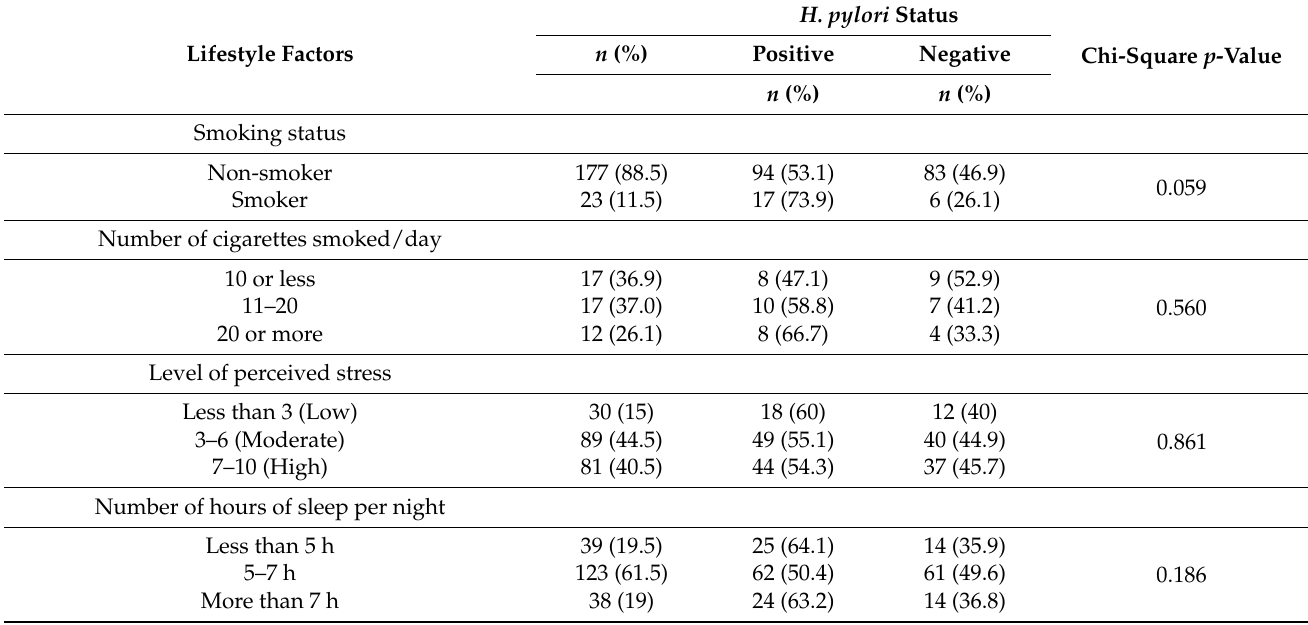
Table 2. Lifestyle factors and their association with H. pylori status among the study